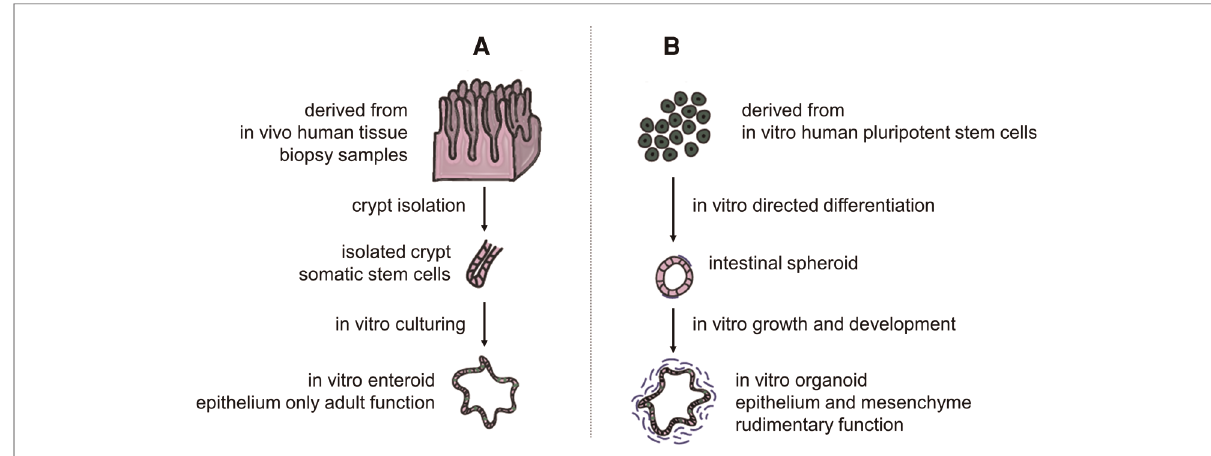
FIGURE 4 Difference between enteroids and organoids. ( A ) Enteroids are human mini-guts resembling the native intestine derived from adult ISCs of isolated crypts in intestinal biopsy samples. (B) Alternatively, intestinal organoids can be directly generated from induced pluripotent stem cells. The terminology, enteroids and organoids, was suggested to differentiate epithelial only in vitro cultures from both epithelial and mesenchymal ones, respectively. Adapted from Singh et al. (139). Open access (CC-BY